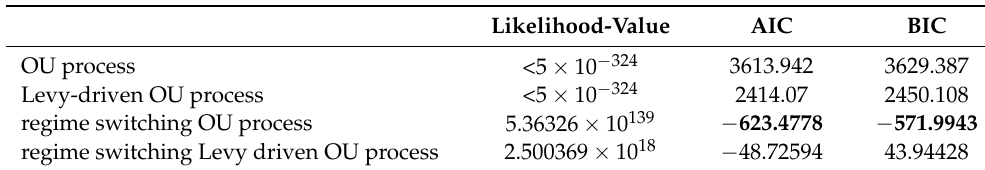
Table 10. Model comparison for fuel-switching data using AIC and BIC, where 5 × 10 − 324 represents the smallest positive double in R.